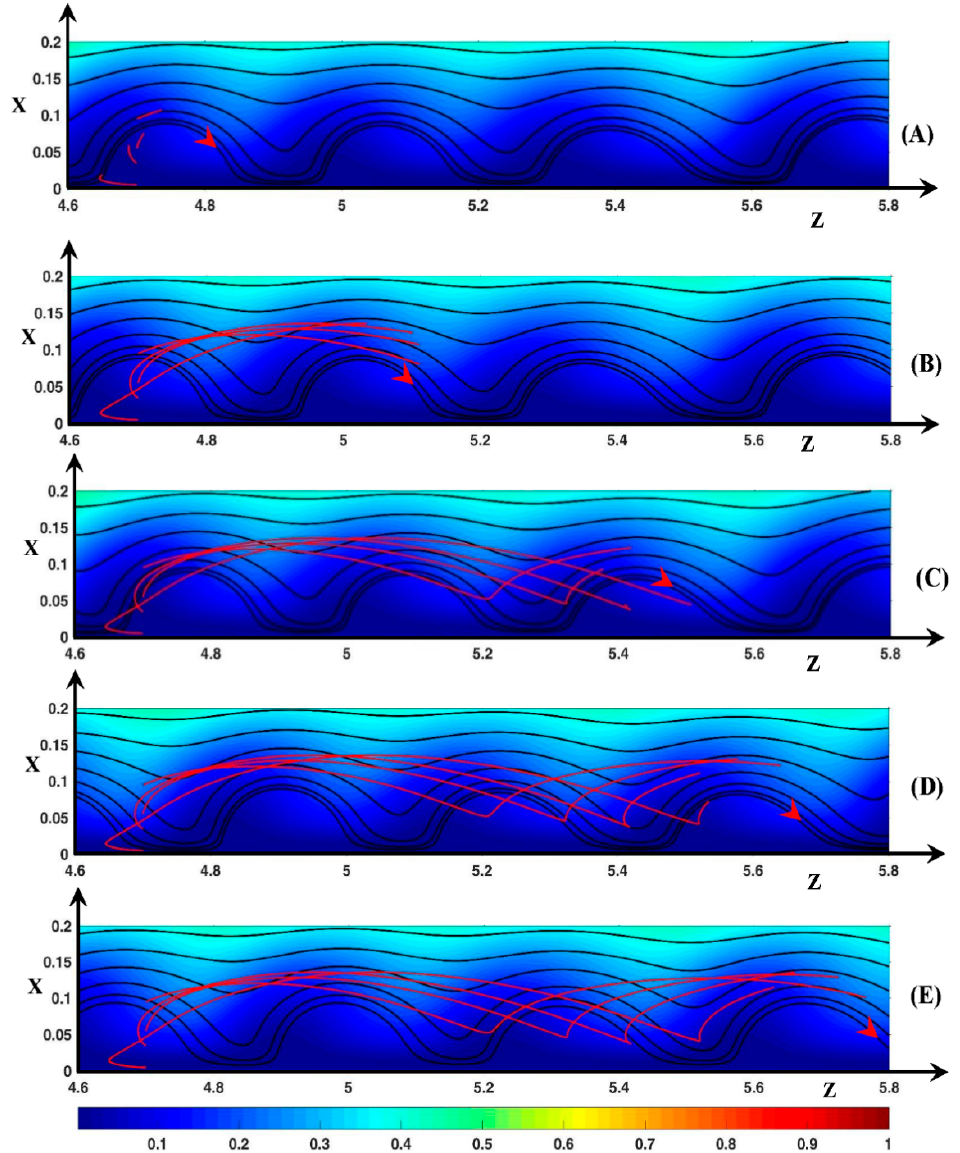
Figure 14. Fluid and anionic trajectories. Black lines: fluid static streamlines starting from the inlet. Red lines: anionic dynamic streamlines starting from z o = 4.7 ( x o = 0.005, 0.035, 0.055, 0.085). Color plot: cation concentration. The red arrow represents the rotation direction of the vortices and the position of the vortex at time t ’ (the trajectories start at t ’ = 0 inside this vortex). ( A ) t ’ = 10; ( B ) t ’ = 95; ( C ) t ’ = 210; ( D ) t ’ = 250; ( E ) t ’ = 275. ∆Φ = 22, ν = 1/3 × 10 − 3 , D ± =